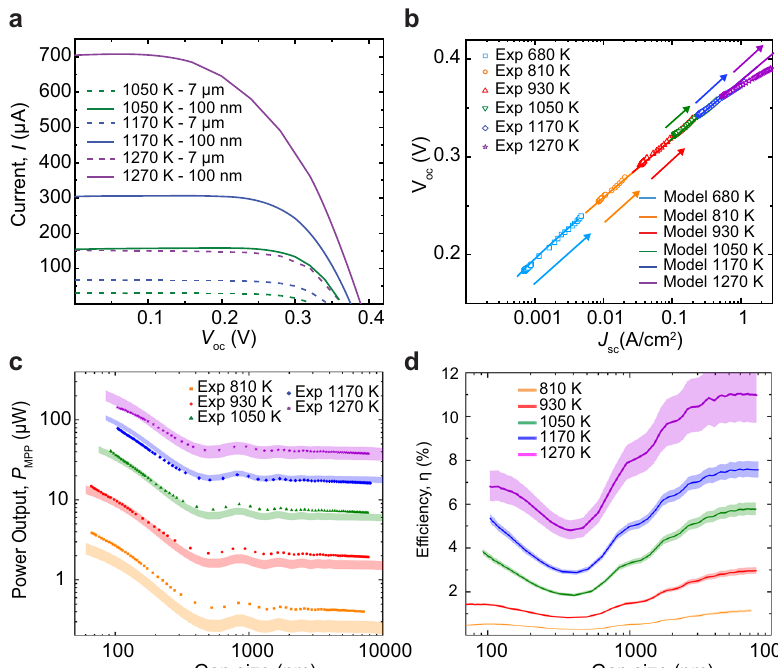
Fig. 3 Performance of the thermophotovoltaic system as a function of temperature and gap size. a Current – voltage ( I – V ) curves obtained at three emitter temperatures and two gap sizes, indicating an upward shift with increasing temperature and reduced gap size. Dashed lines and solid lines correspond to 7- µ m and 100-nm gap sizes, respectively. b V oc (open-circuit voltage) as a function of J sc (de fi ned as short-circuit current ( I sc ) per unit area of the PV cell) obtained from experimental data (various symbols) and calculations (solid lines) at all temperatures. The arrow direction indicates decreasing gap size. At high temperatures, there is some overlap in the data sets. c , The experimentally measured power output ( P MPP ) at different temperatures as a function of gap size, indicating power enhancements as the gap size is reduced from 7 µ m to 100 nm. The shaded regions indicate the theoretical power output ( P MPP ) based on our model in a temperature range of T emitter ± Δ T , Δ T = 27 K for T emitter = 1270 K and 10 K otherwise. d The ef fi ciency ( η ) de fi ned as the ratio of P MPP to the calculated total radiative heat transfer ( Q RHT ) at different temperatures of the emitter as a function of gap size. The solid lines correspond to the ef fi ciencies obtained by calculating Q RHT at T emitter , while the shaded regions correspond to the ef fi ciencies due to the uncertainty ( Δ T ) in the measurement of T emitter .